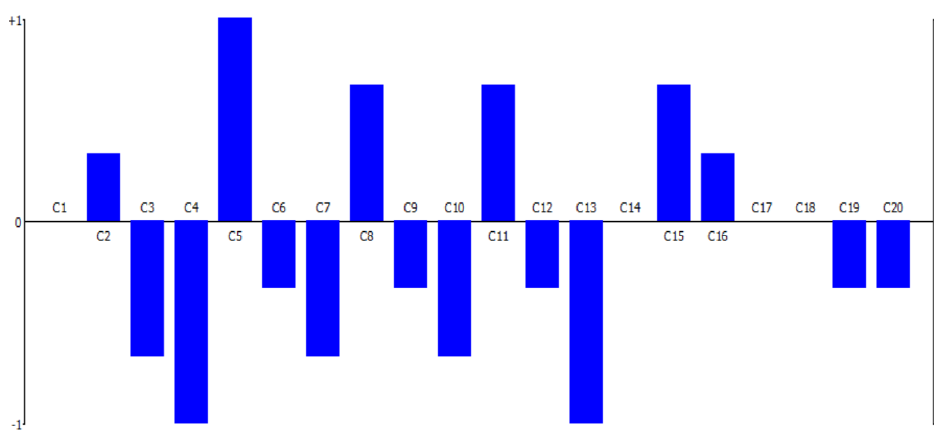
Figure 4. Scoring map of J community for resilience adapted to FFE.